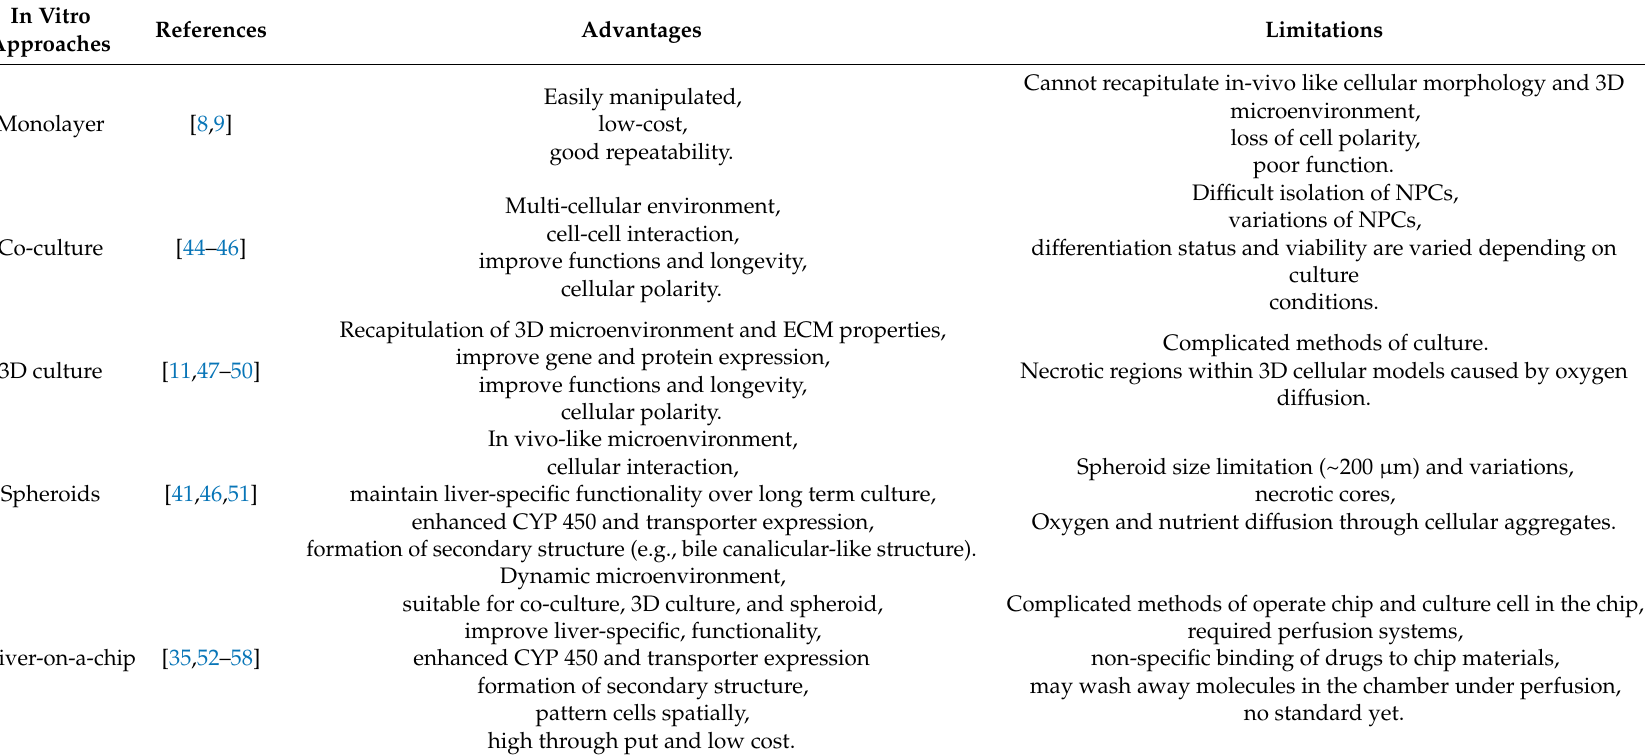
Table 2. Advantages and limitations of in vitro liver models (note: these methods may have